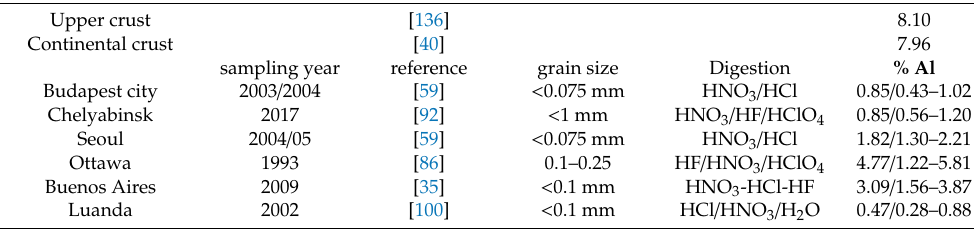
Table A21. Aluminum in road